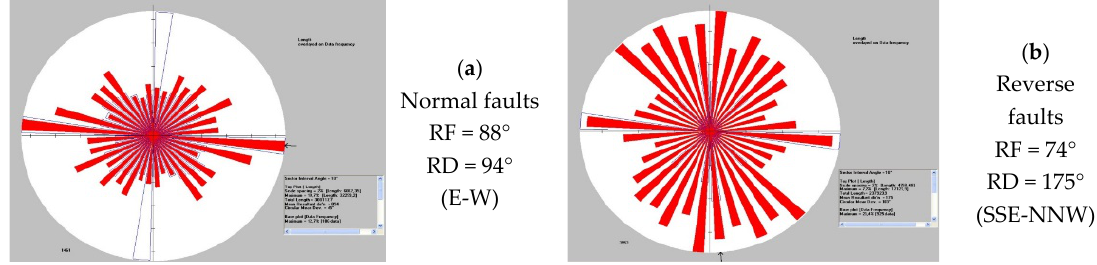
Figure 8. Rose diagrams of frequency (RF) and density (RD) for ( a ) high angle normal faults and ( b ) small-angle reverse faults (overthrust, thrust).